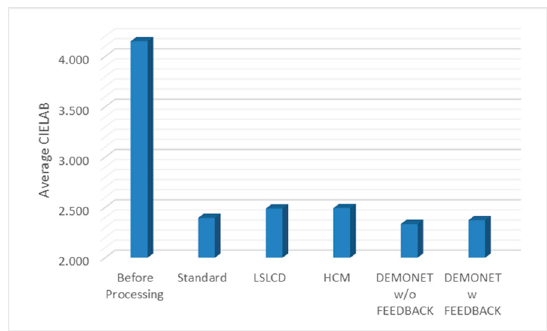
Figure 13. Averaged PSNR values of different methods for RGB bands.